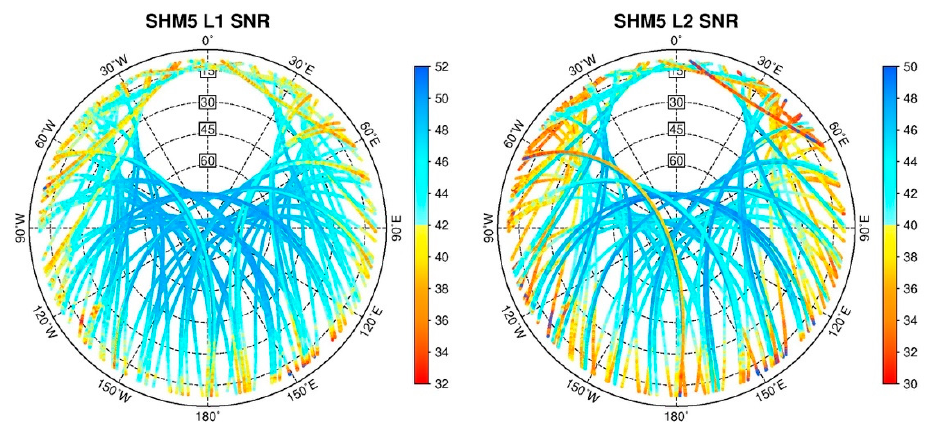
Figure 12. SNR-based sky-plot of GPS and GLONASS at SHM5.